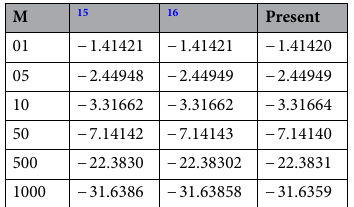
Table 2. Comparison values of Skin friction co-efficient ( B =